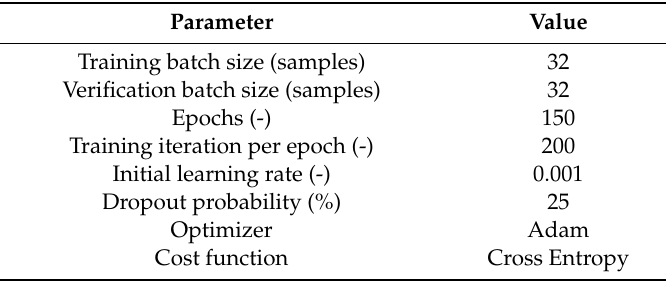
Table 4. Hyper-parameters used for training the two U-NET